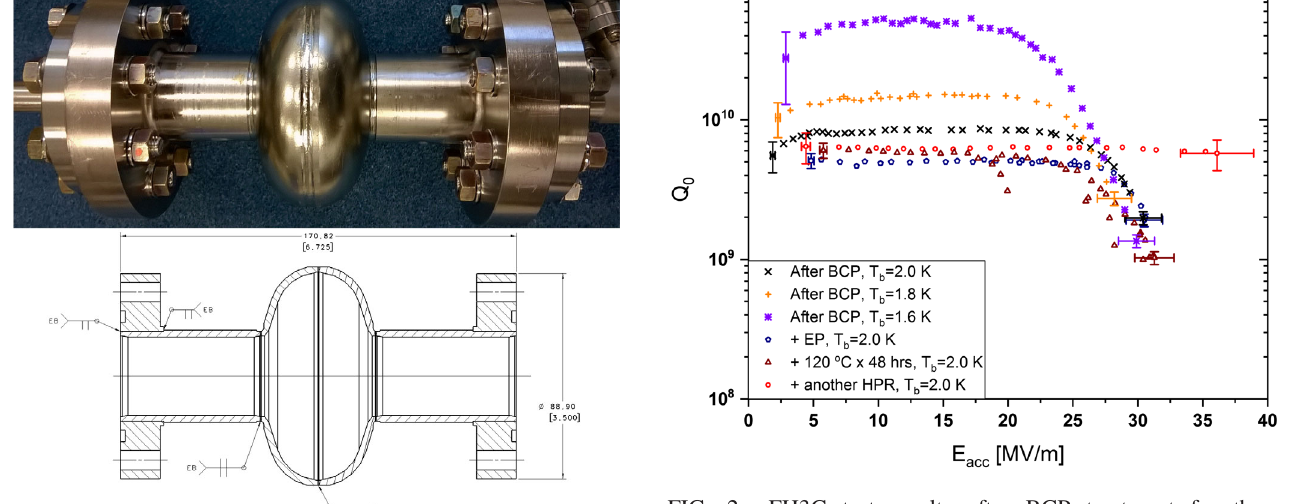
FIG. 2. FH3C test results after BCP treatment for three different helium bath temperatures, 2.0, 1.8, 1.6 K and after EP treatment and mild baking at T b ¼ 2 . 0 K. Note the increase in the low-field quality factor as expected for lower helium bath temperatures, but similar Q drops. Also, note the absence of the high-field degradation in the test after the EP and mild baking.